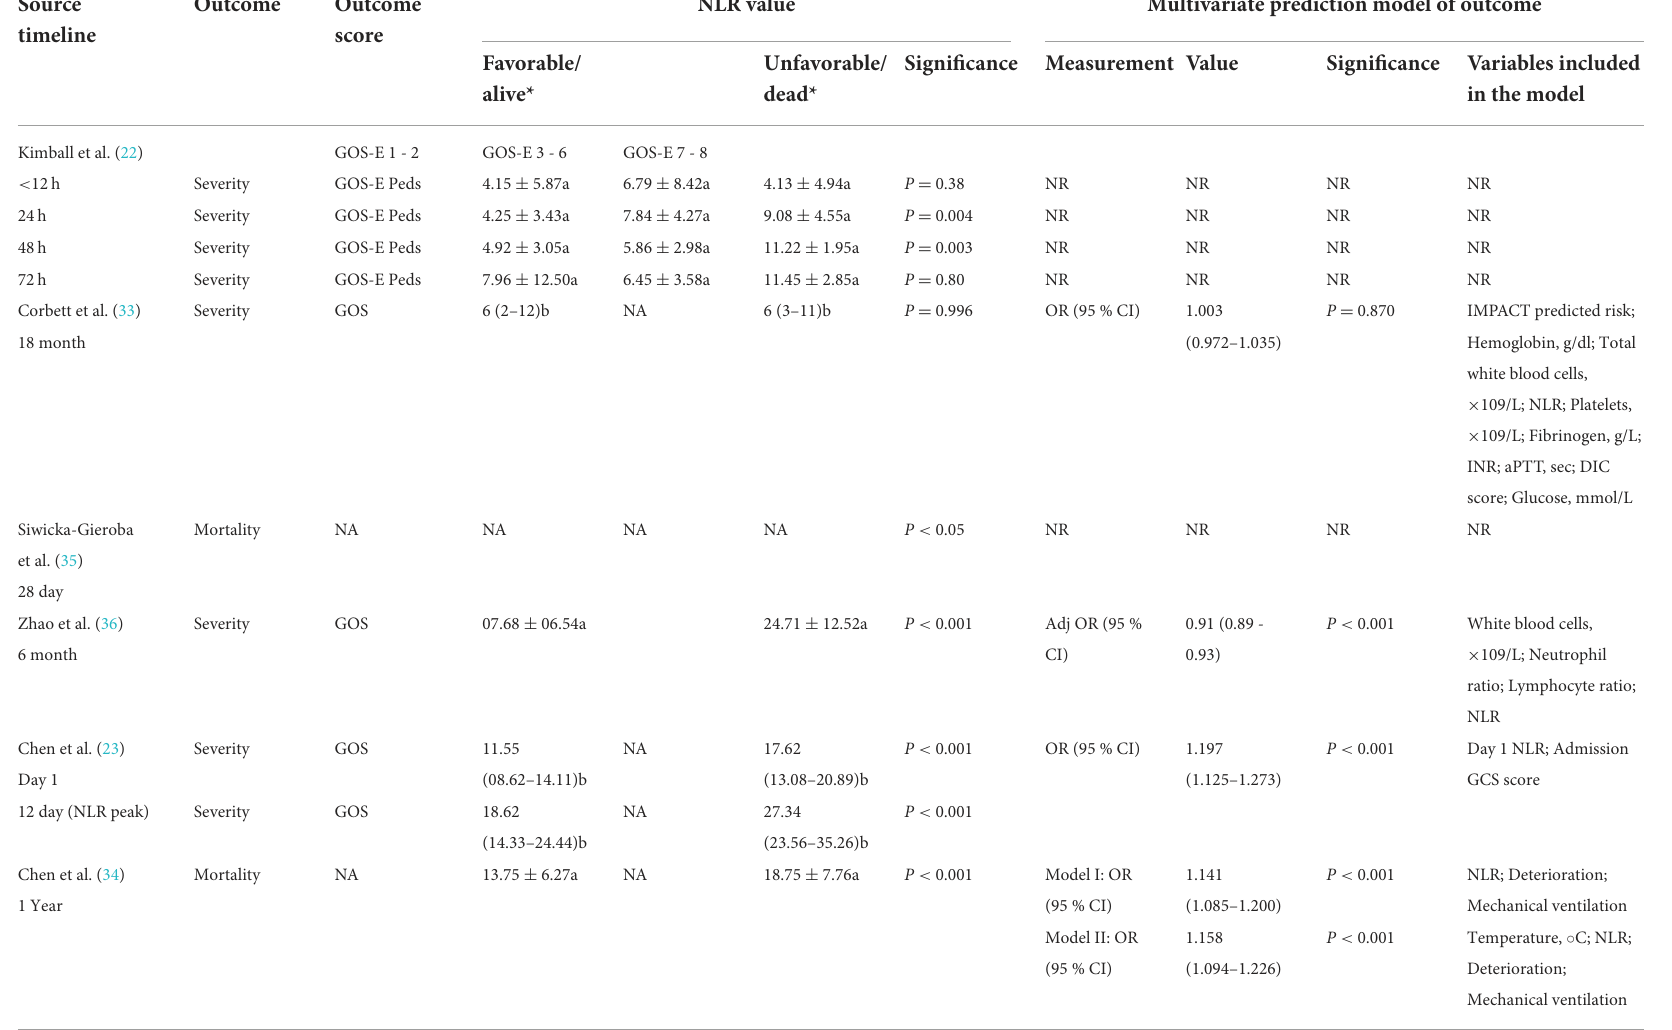
TABLE 3 NLR value and prediction according to worse